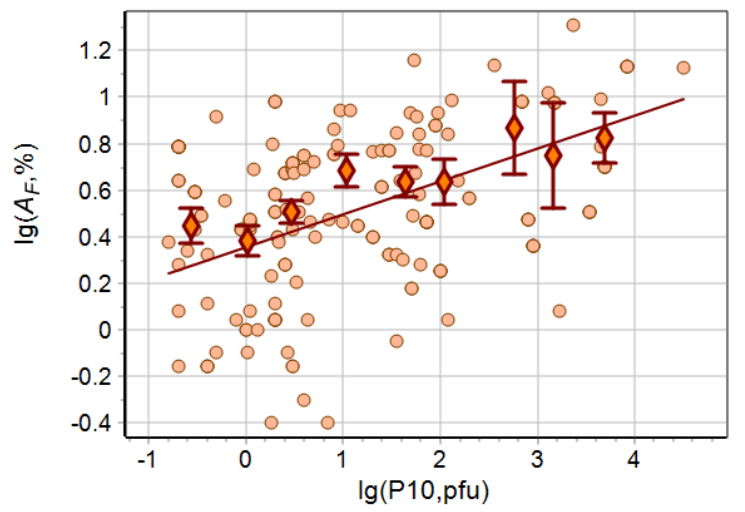
Figure 8. Relationship (lg–lg) between the FD amplitude ( A F ) and the peak proton flux for particles with energy E > 10 MeV ( P 10) in events with the same solar